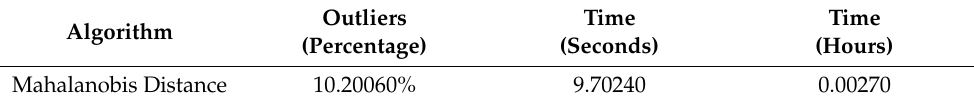
Table 5. Results of multivariate outlier detection analysis using Mahalanobis Distance.